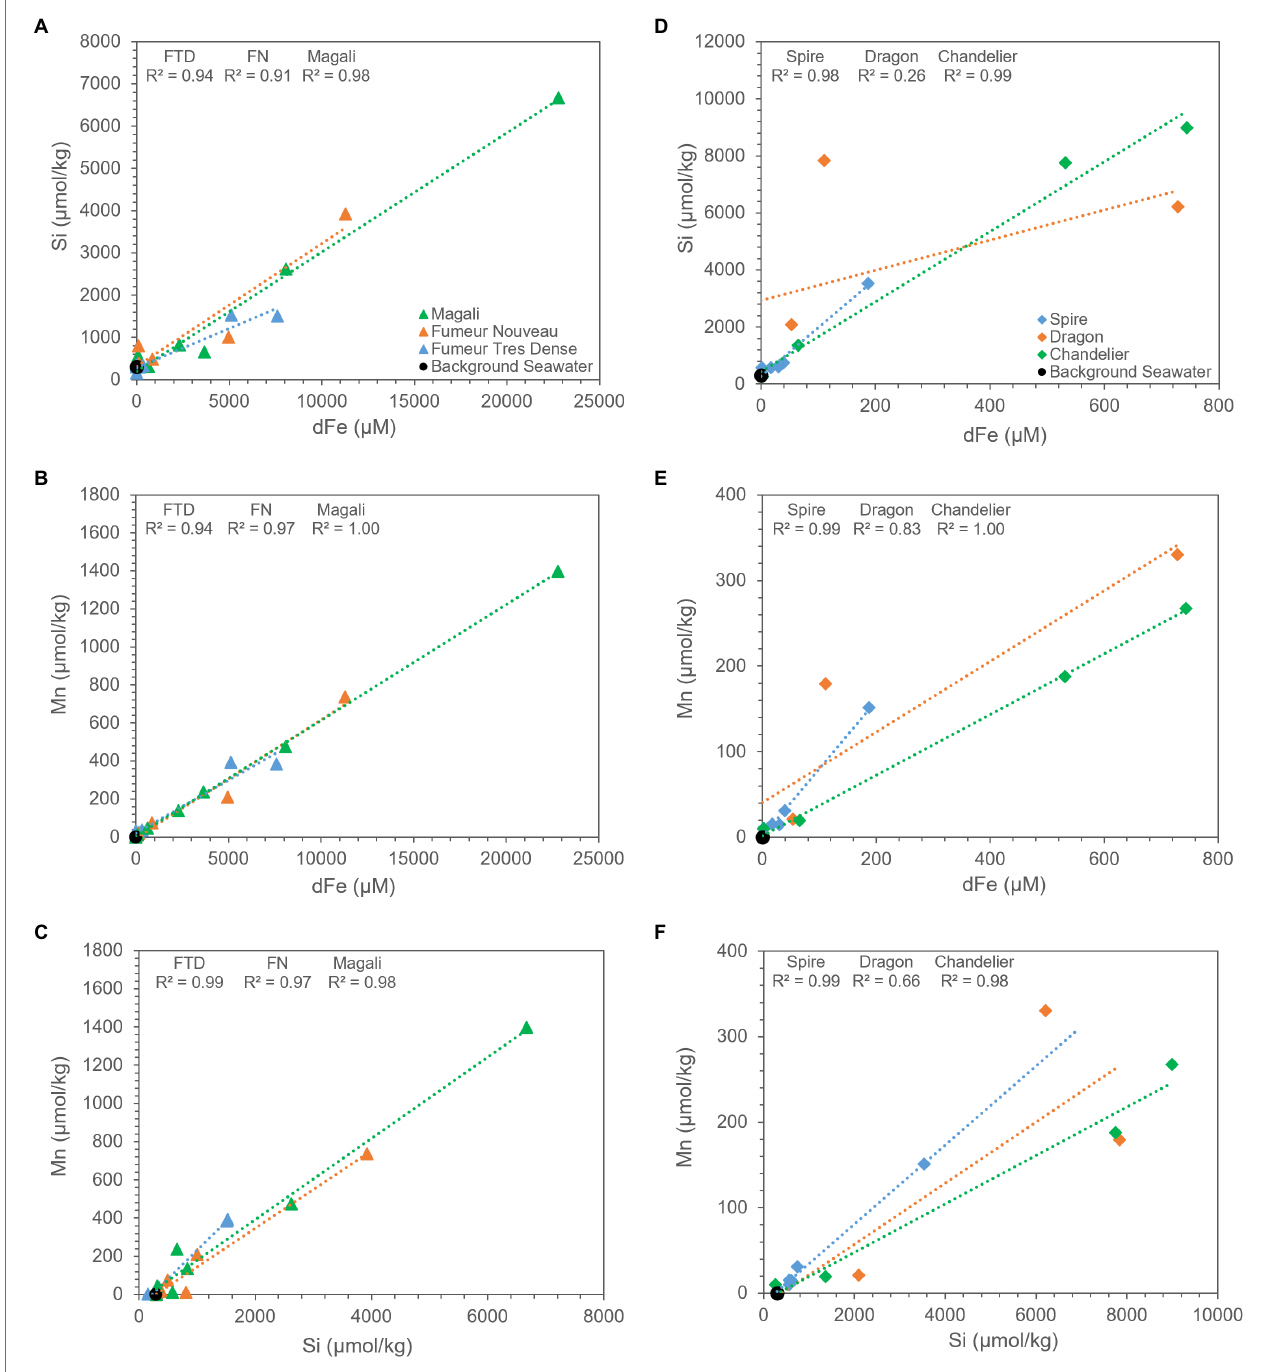
FIGURE 6 | Relationship between measured concentrations of dissolved iron, Si, and Mn in Rainbow (A–C) and Broken Spur (D–F) vents. Rainbow fluids exhibit very high correlation with Si and Mn in all its vents likewise Broken Spur vent fluids except for Dragon XIII, where scarcity in data might create deviation from correlation for both Si and Mn. Statistical parameters are given on the